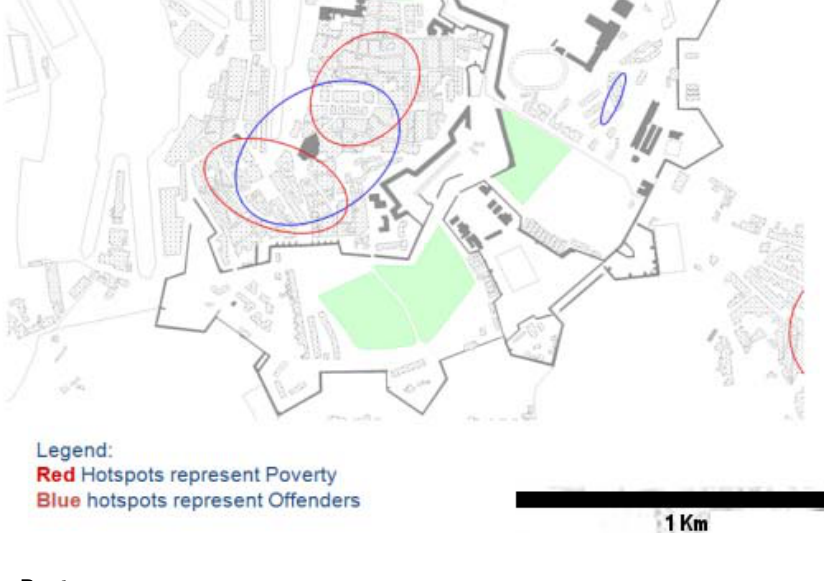
Figure 1. Crime Maps—Overlaying Offender and Poverty Hotspots.